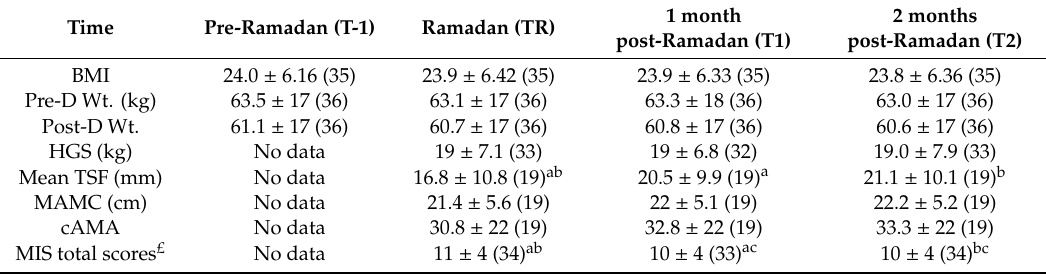
Table 5. Anthropometric assessment and malnutrition-inflammation